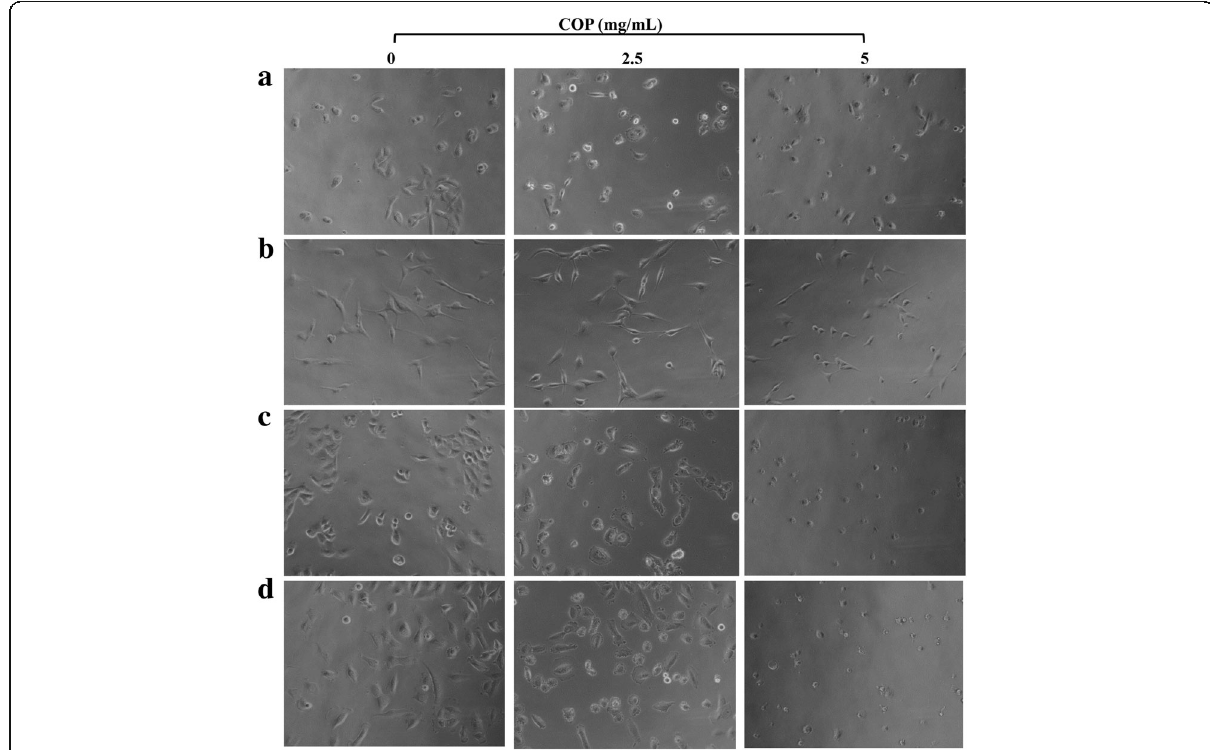
Fig. 1 Effect of COP on proliferation of Glioma cells. U251 ( a ), U87 ( b ), H4 ( c ) and LN229 ( d ) cells were treated with COP (0, 2.5 and 5 mg/ml) for 24 h, respectively. Photographs of cell are